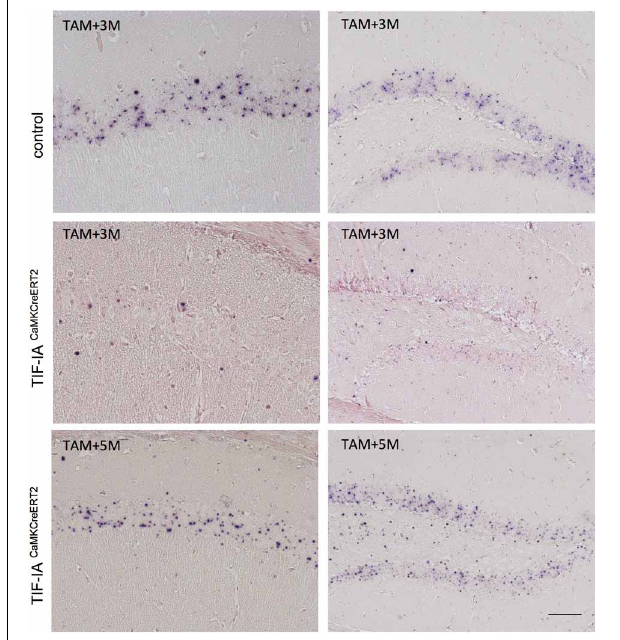
FIGURE 4 | Nucleolar integrity is restored in CA1 and DG of TIF-IA CaMKCreERT2 mutants. Representative images of IHC with the nucleolar markers nuclephosmin (NPM/B23) in control and TIF-IA CaMKCreERT2 mutant mice 3 months after tamoxifen showing reduced intensity of nucleolar staining and re-localization to the nucleoplasm in the CA1 and mostly DG of mutants. Five months after tamoxifen TIF-IA CaMKCreERT2 show intense staining of NPM/B23 in the nucleoli. Scale bar: 60 μ m.